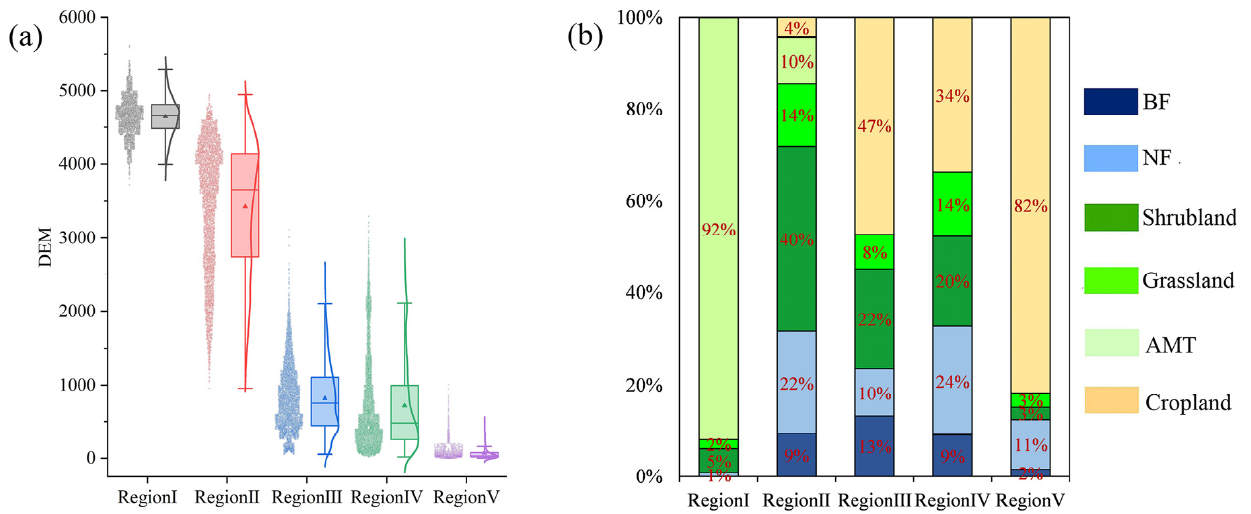
Figure 8. The ( a ) elevation ranges and ( b ) percentages of different vegetation types in subregions.